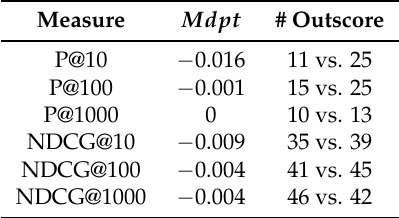
Table 26. T2: comparison of the best run vs. the CombSUM fusion of the two best runs. Measure Mdpt # Outscore P@10 − 0.014 8 vs. 19 P@100 − 0.001 16 vs. 26 P@1000 0 7 vs. 8 − 0.009